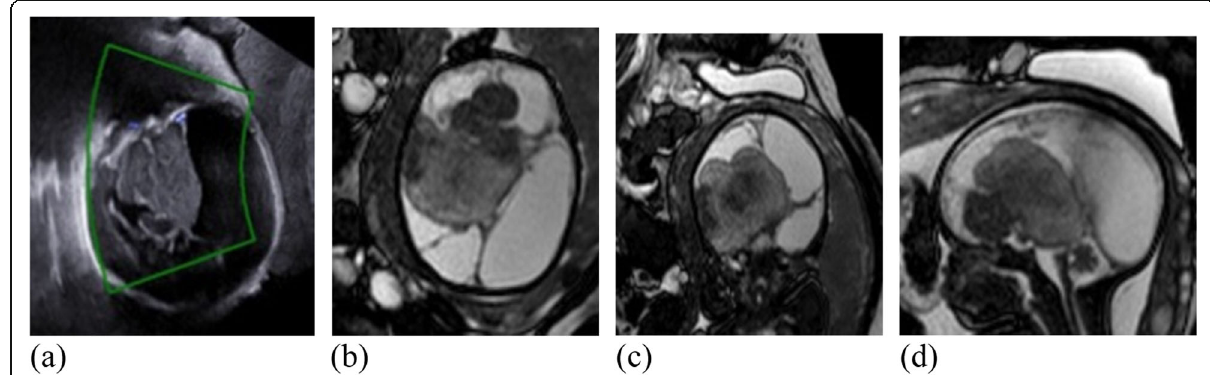
Fig. 2 Twenty-eight-week fetus a US axial plane shows right para-midline suprasellar mass lesion with consequent supratentorial hydrocephalus. b – d MRI (B-FFE) axial, coronal, and sagittal planes confirmed the presence of large supra-sellar mass with better delineation of its extent, mass